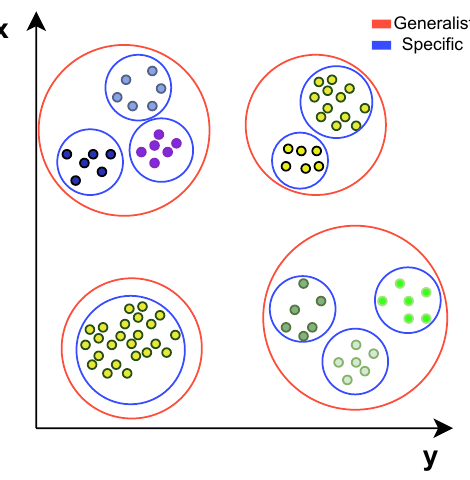
Figure 3. Using labels to cluster